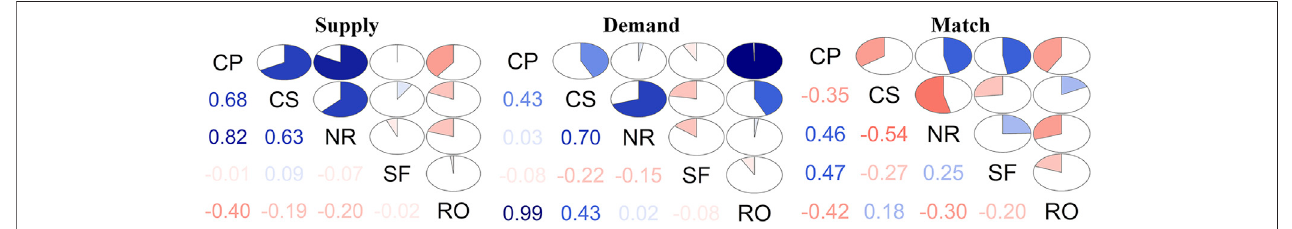
FIGURE 4 | Correlation coef fi cients among ESs at three sides of supply, demand, and match degree (blue for positive correlation, red for negative correlation; CP — crop production, CS — carbon sequestration, NR — nutrient retention, SF — sand fi xation, RO — recreational opportunity).